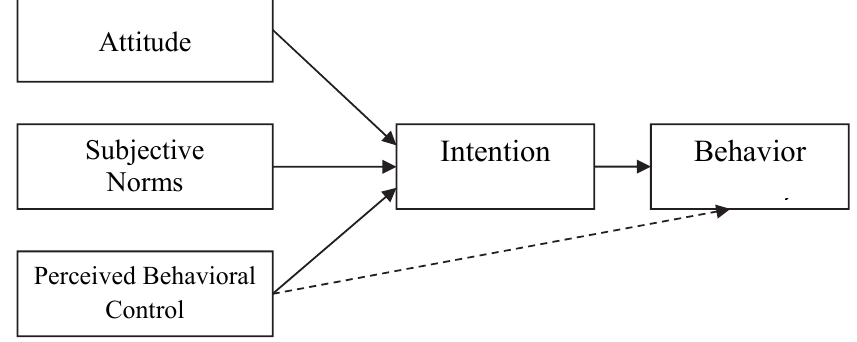
Fig. 2. Theory of Planned Behavior (TPB)